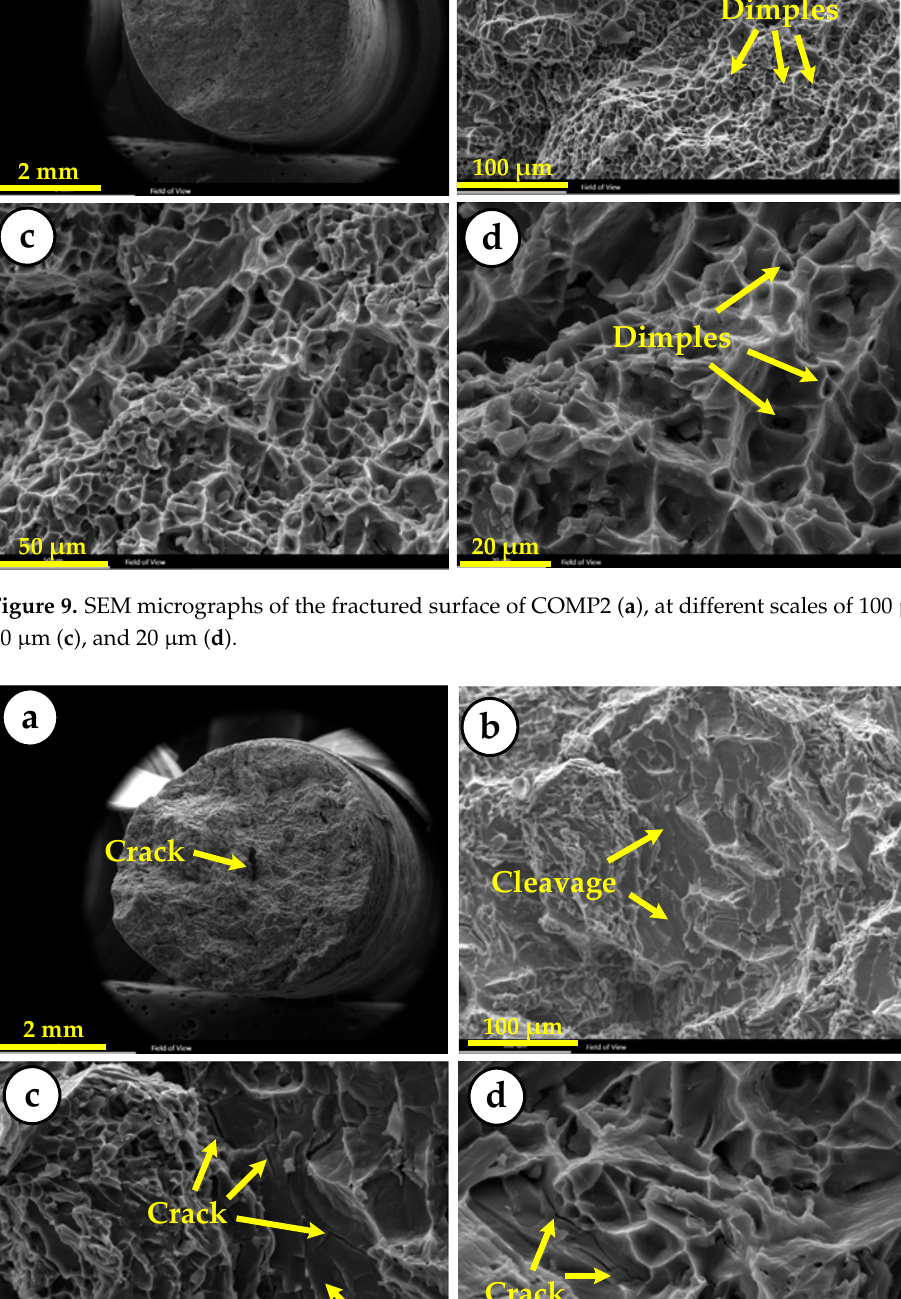
Figure 10. SEM micrographs of the fractured surface of COMP4 ( a ), at different scales of 100 µm ( b ), 50 µm ( c ), and 20 µm ( d ).